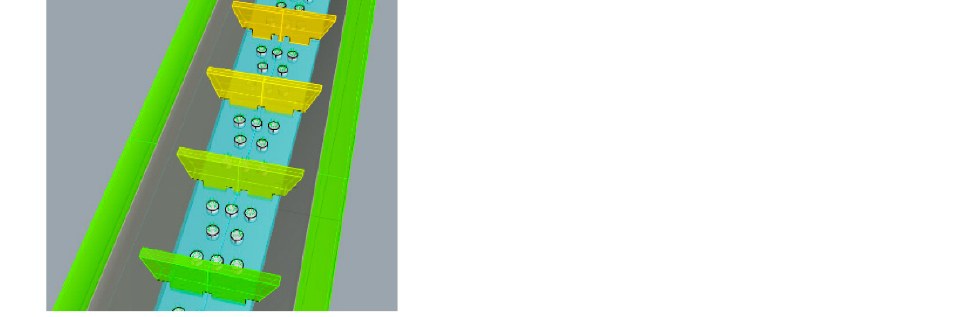
Figure 20. Local 3D simulation model. The interval between the DWO plates is 5 m. The bottom roughening boulders are staggered to increase the roughness as well as reduce the velocity, making it easier for migrating fish.